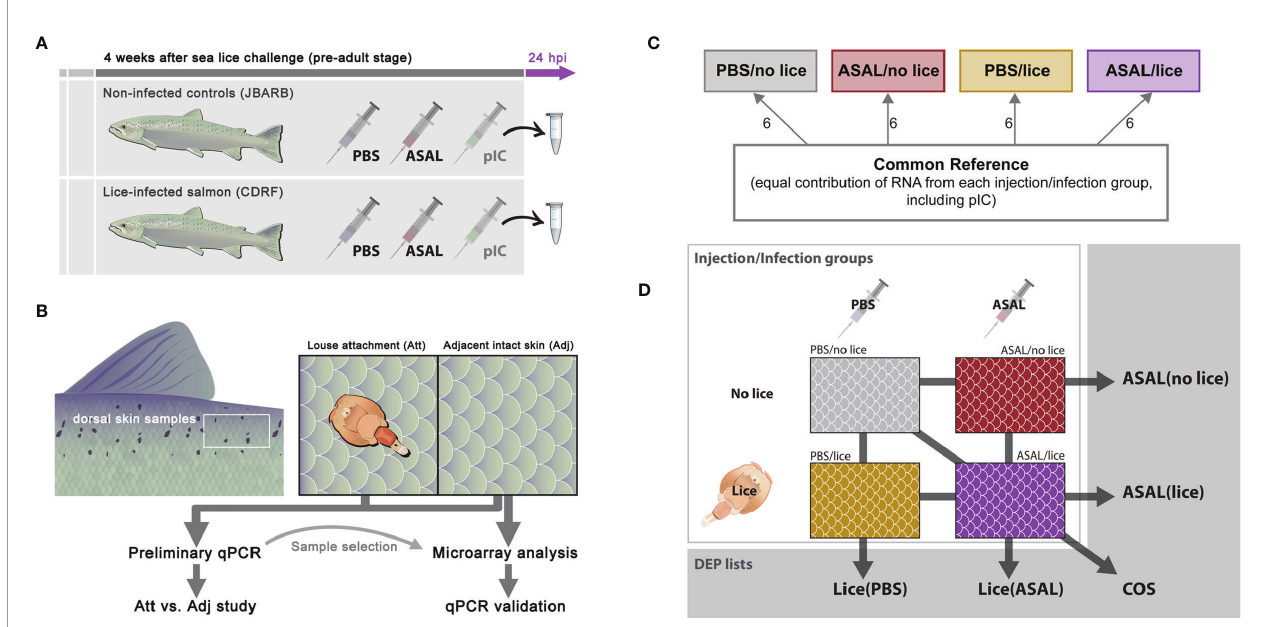
FIGURE 1 | Experimental design of (A) Lice/ASAL co-stimulation trial, (B) skin sample collection on lice-infected salmon (C) 44K microarray experimental design, and (D) microarray data comparisons between injection/infection